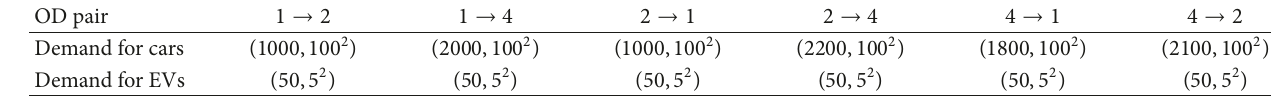
Table 3: Travel demand distributions for two classes of users.